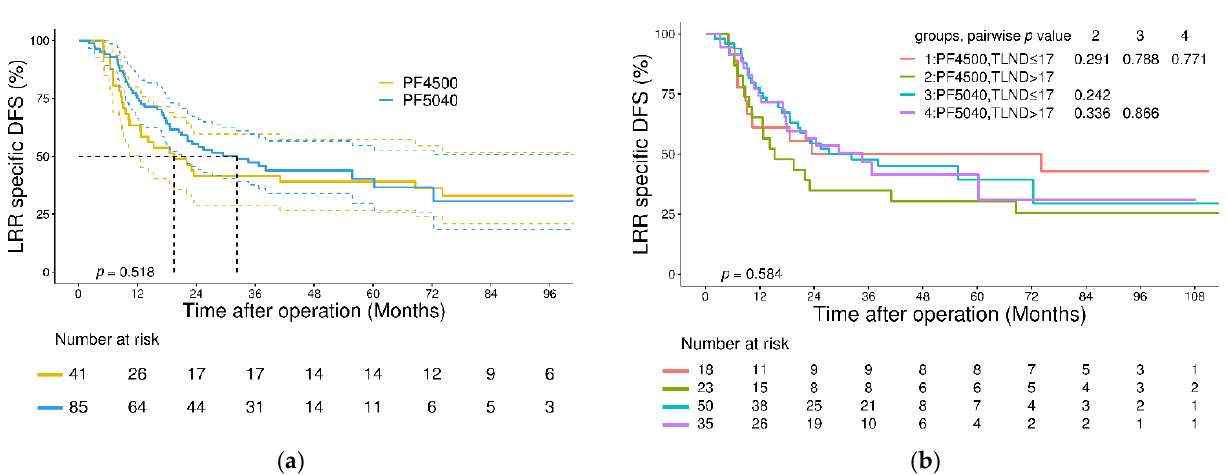
Figure 3. ( a ) Kaplan–Meier analysis of LRR specific disease-free survival in the entire cohort stratified according to regimens; ( b ) Kaplan–Meier analysis of LRR specific disease-free survival in the entire cohort stratified according to regimens and total LND numbers. Abbreviations: LRR: locoregional recurrence; DFS: disease-free survival; TLND: total lymph node dissection.